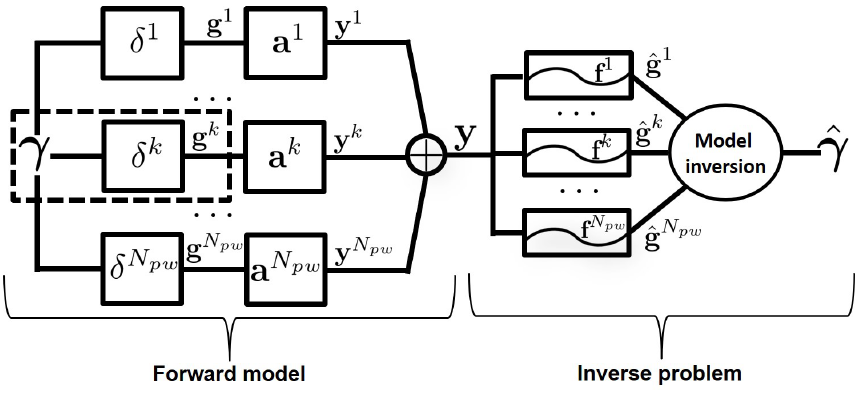
Figure 1. a—Schematic representation of the proposed imaging approach. γ —tissue reflectivity function; δ ( k ) —short electrical excitation of the k th wave; g ( k ) —received echoes that correspond to the emission of δ ( k ) ( k th wave); a ( k ) —code carried by the k th wave; y ( k ) —received echoes after emission of a ( k ) ; y —recorded echoes when N pw plane waves are emitted simultaneously; f ( k ) — optimal compression filter that corresponds to the k th wave; and ˆ g ( k ) —estimation of g ( k ) obtained from y . Finally, an estimation ˆ γ of the tissue reflectivity function γ is obtained by solving the inverse